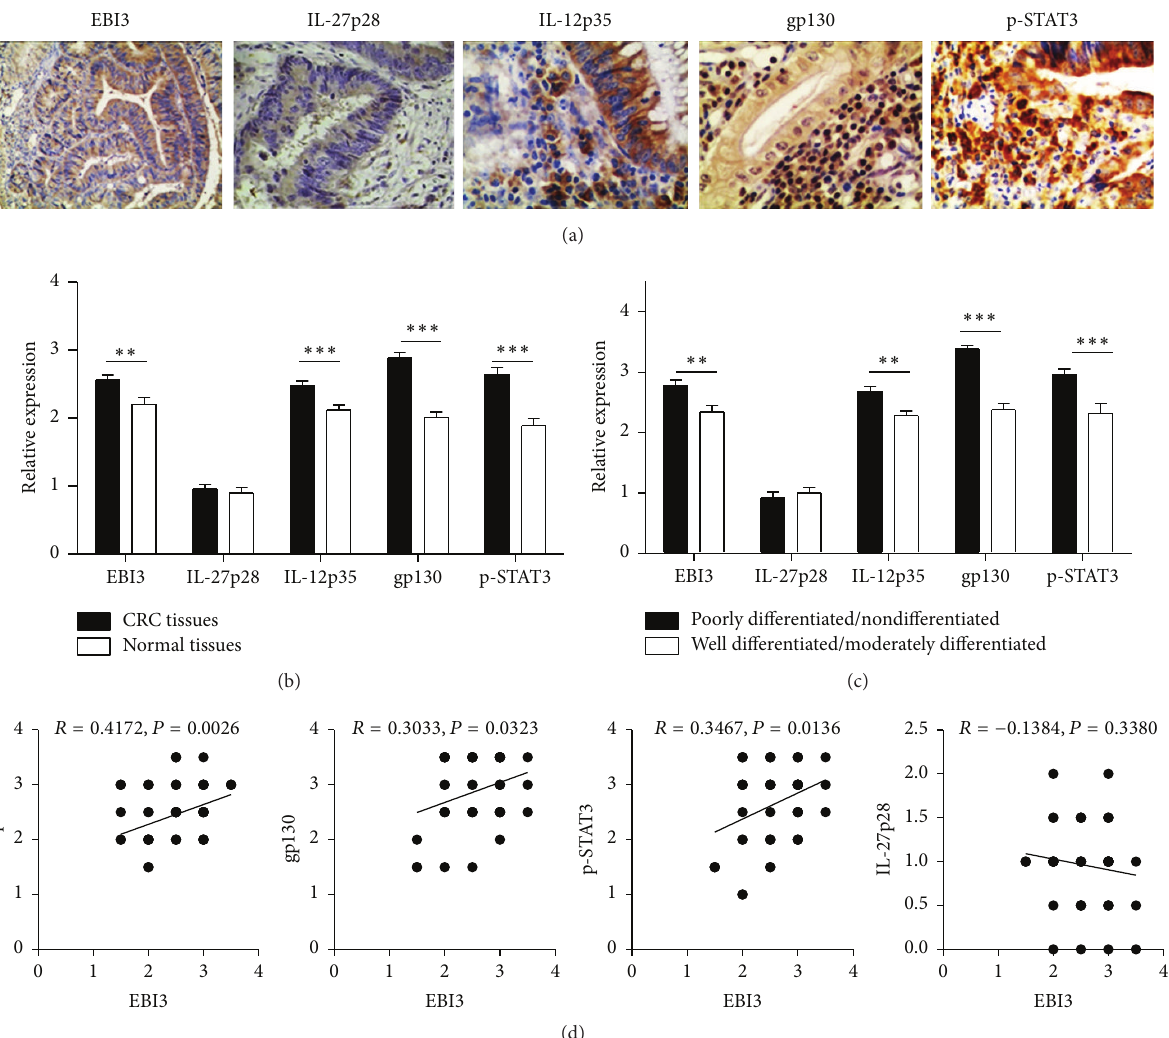
Figure 1: Quantitative analysis of EBI3, IL-27p28, IL-12p35, gp130, and p-STAT3 expression in CRC tissues by immunohistochemistry. (a) Representative images for the immunohistochemical staining of EBI3, IL-27p28, IL-12p35, gp130, and p-STAT3 in CRC tissues (400x). (b and c) Bar graphic figures showing the relative expression levels of EBI3, IL-27p28, IL-12p35, gp130, and p-STAT3 assessed in all tissues. (d) Results for correlation analysis of EBI3 with IL-27p28, IL-12p35, gp130, and p-STAT3 in CRC tissues. ∗∗ 𝑃 < 0.01 ; ∗∗∗ 𝑃 < 0.001